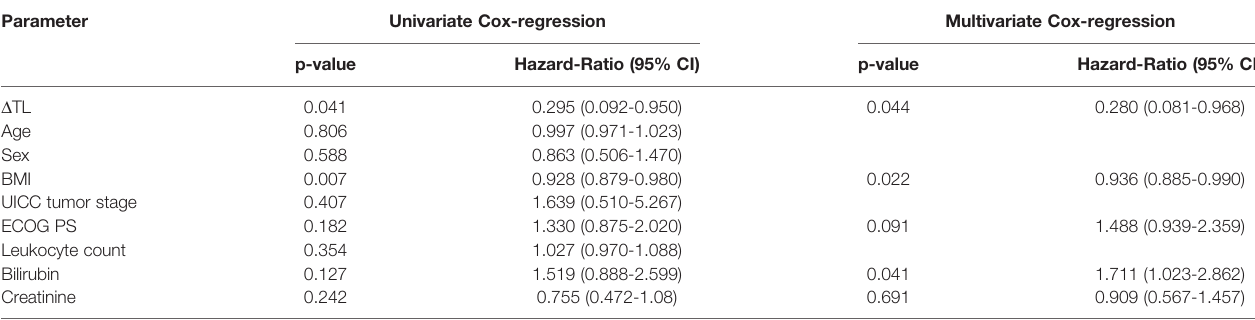
TABLE 2 | Uni- and multivariate Cox-regression analysis for the prediction of overall survival. Parameter